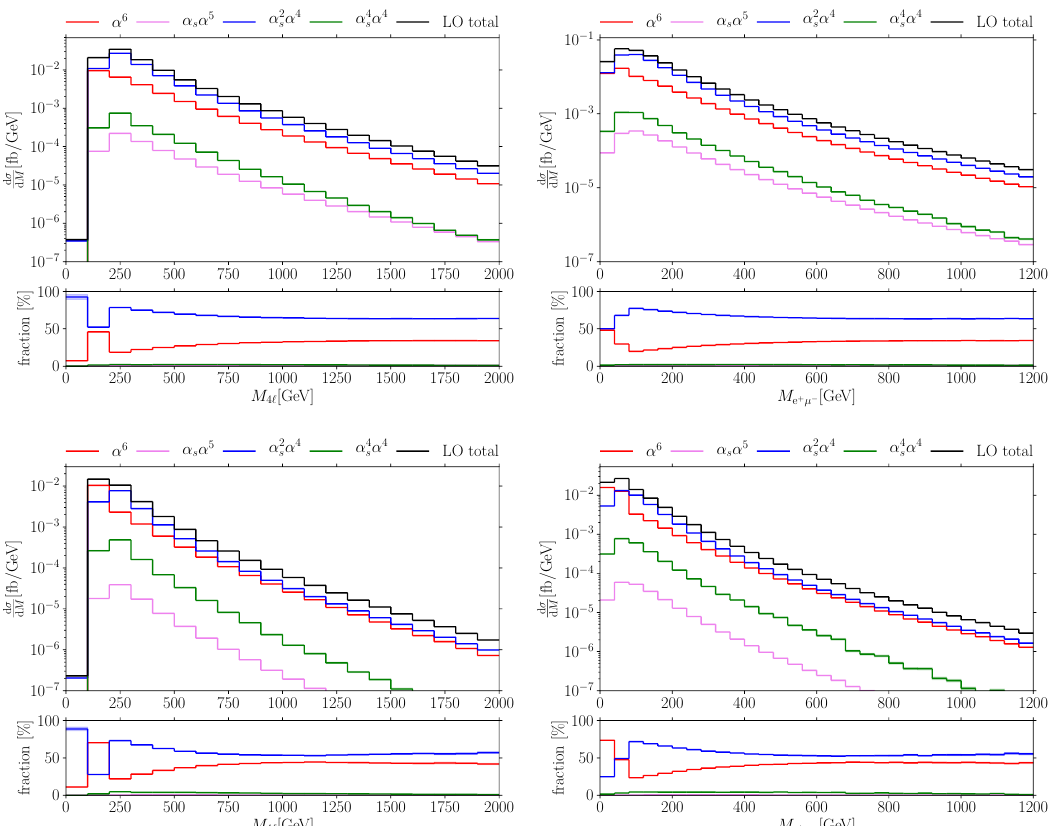
Figure 8. Differential distributions at LO in the invariant mass of the four final-state leptons (left) and the invariant mass of charged leptons (right) in the VBS setup (top) and the Higgs setup (bottom). The upper panels show the absolute EW contribution at (cid:0) (cid:1) α s α 5 , the QCD contribution at O sum of all contributions. The lower panels show the relative contribution normalised to the sum. Shaded bands denote integration